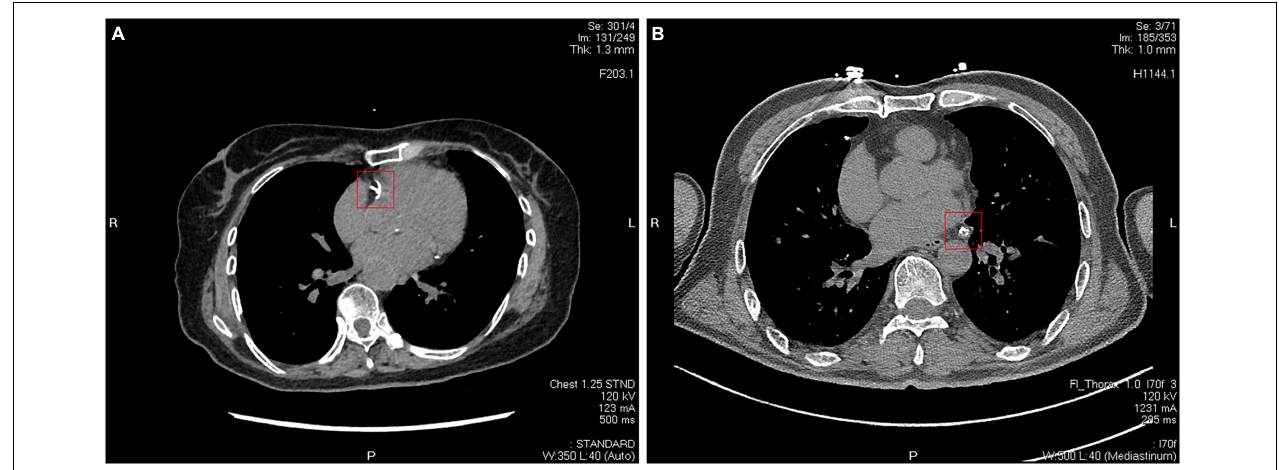
FIGURE 4 | Two different CT images of coronary artery calcification. (A) Calcifications in the right coronary artery indicated by a red square. (B) Calcifications in the circumflex branch of the left coronary artery indicated by a red